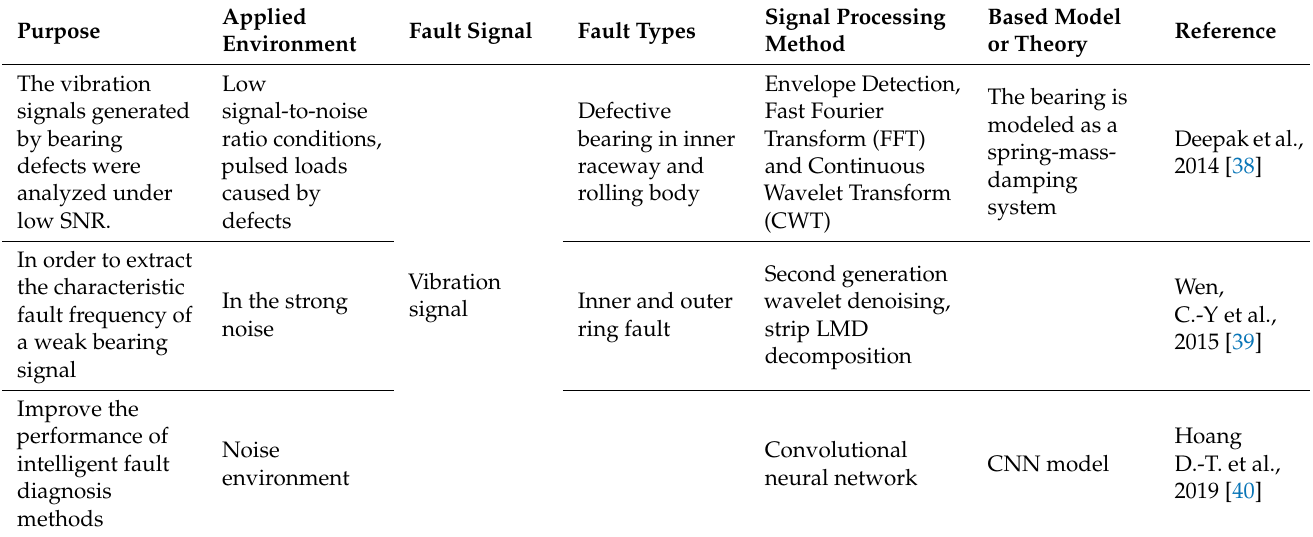
Table 2. Summary and comparison table of vibration signal analysis